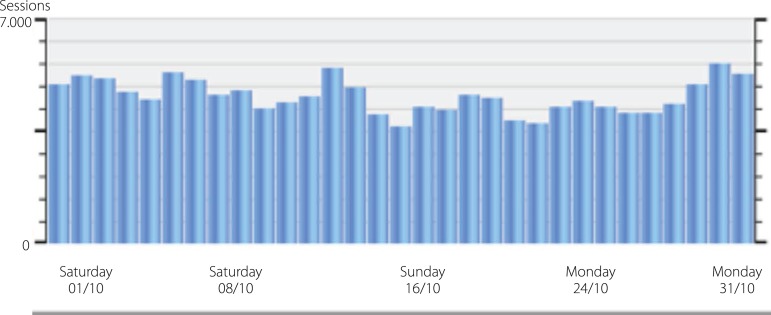
Accesses in October.